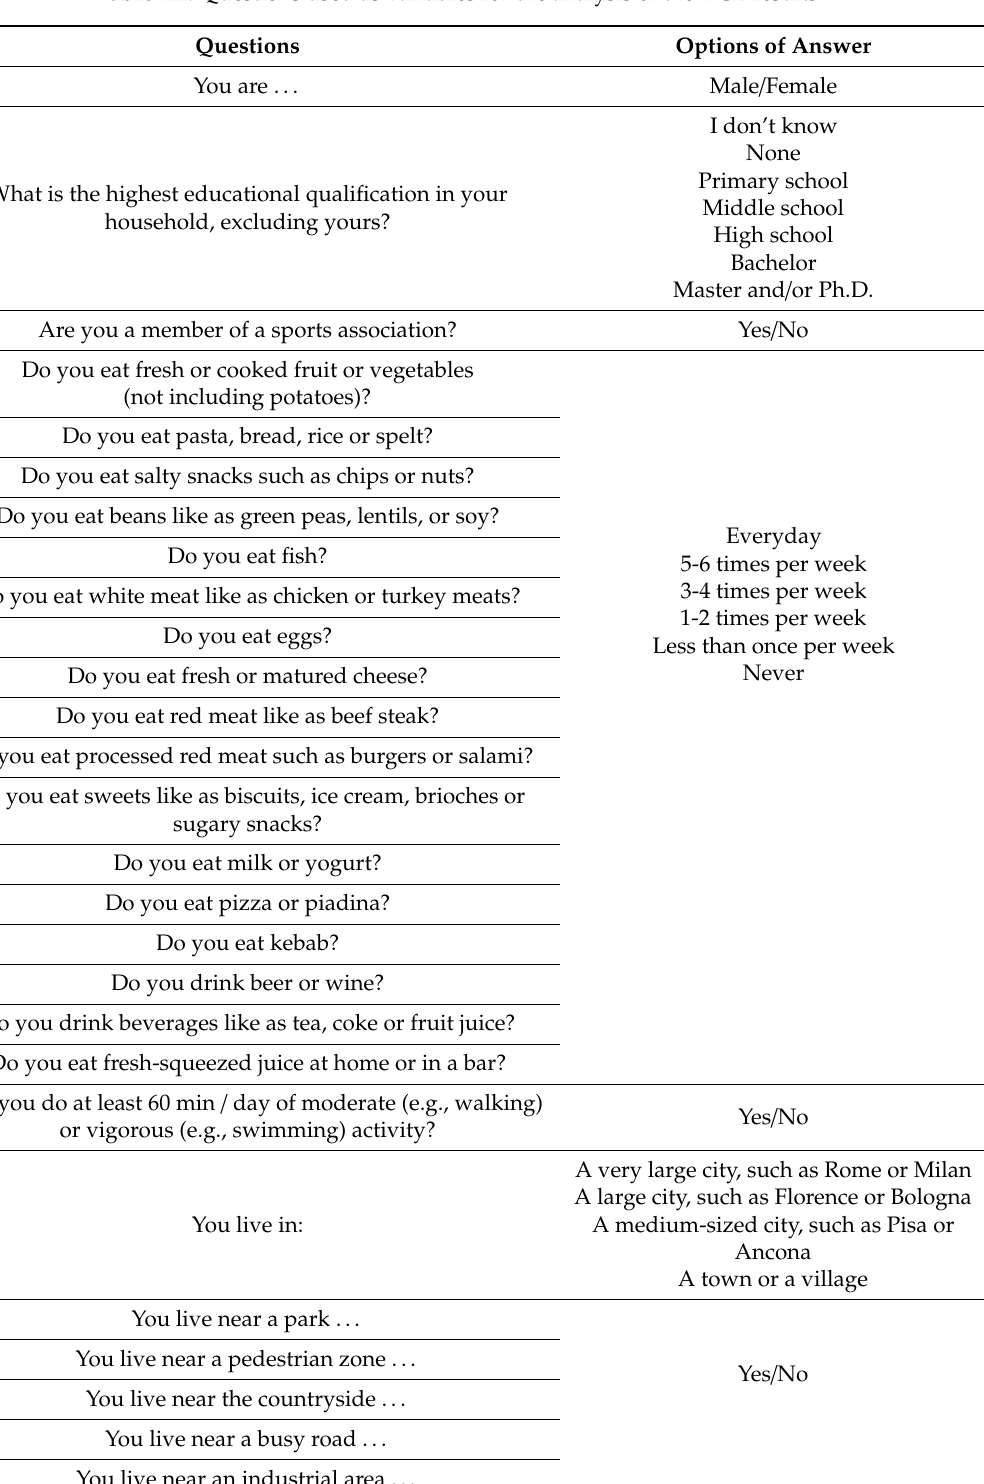
Table A1. Questions used as variables for the analysis of the DCE